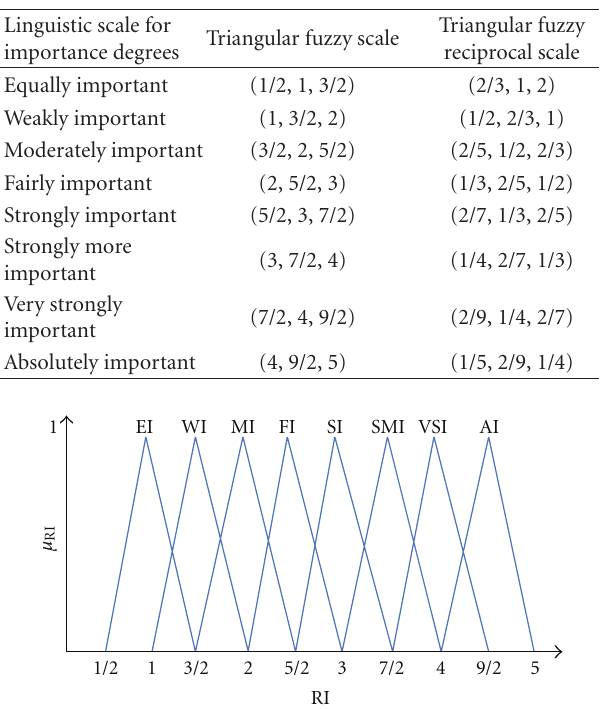
Figure 1: The linguistic scale of fuzzy triangular numbers.